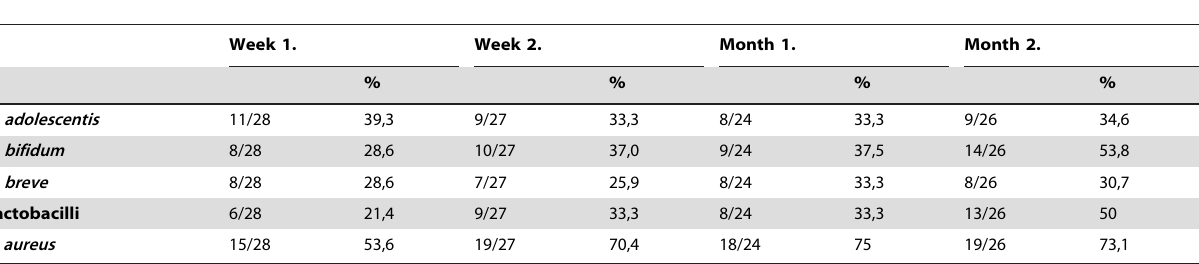
Table 1. Percentages of infants colonized with respective bacteria.